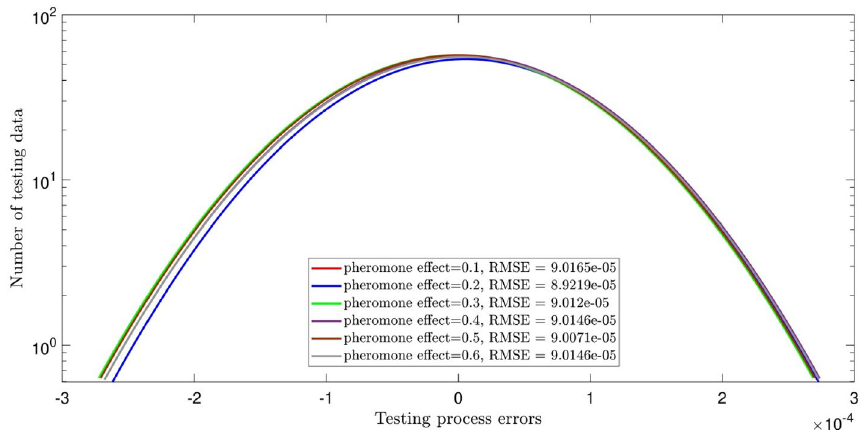
Figure 2. ACOFIS learning processes using two inputs and diversity of pheromone effect.